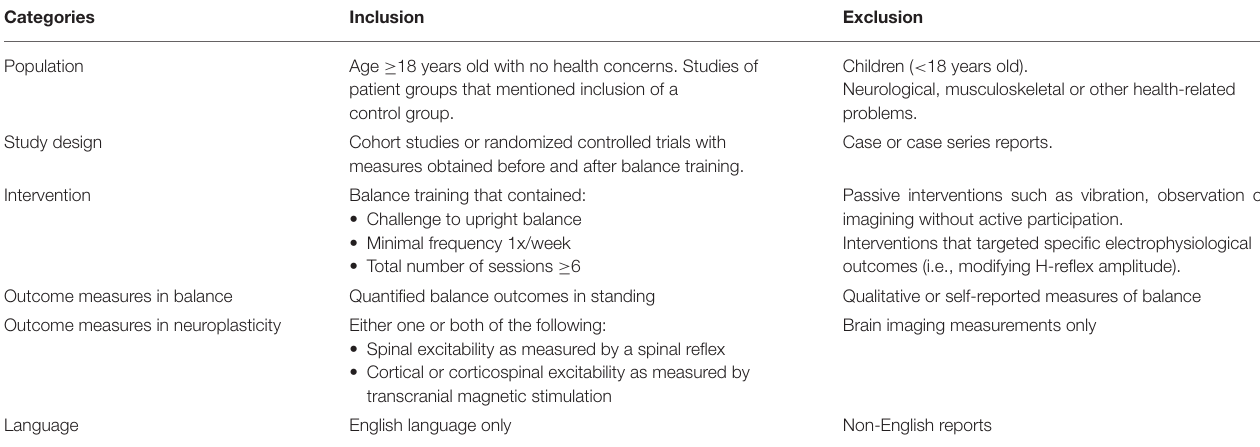
TABLE 1 | Inclusion/exclusion